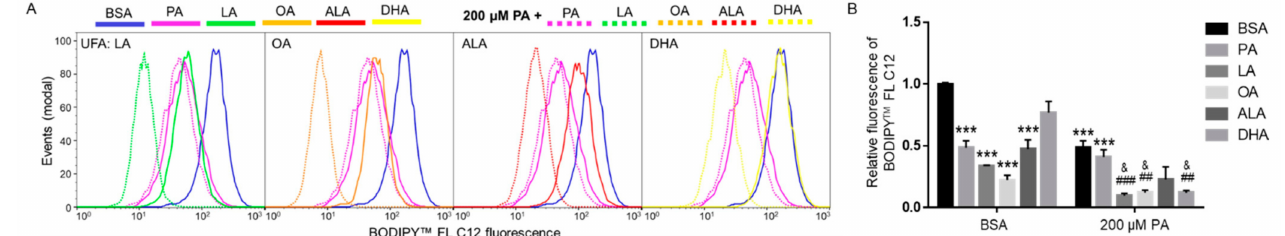
Figure 7. Uptake of BODIPY TM FL C12 in BV2 cells following treatment with BSA or PA together with different FFAs. Cells were treated with BSA or 200 µ M PA together with 200 µ M of different FFAs in serum-free media for 6 h. At the end of treatment, cells were incubated with BODIPY TM FL C12 for 30 min and FA uptake was measured by flow cytometry with representative histograms shown in ( A ) and quantitated data shown in ( B ). Data presented (mean ± SEM) were representative of three independent experiments. Statistical analysis was performed using two-way ANOVA followed by Tukey’s multiple comparison test. *** p < 0.001 vs. BSA control; ## p < 0.01 vs. 200 µ M PA; ### p < 0.001 vs. 200 µ M PA; & p < 0.05 vs. 400 µ M